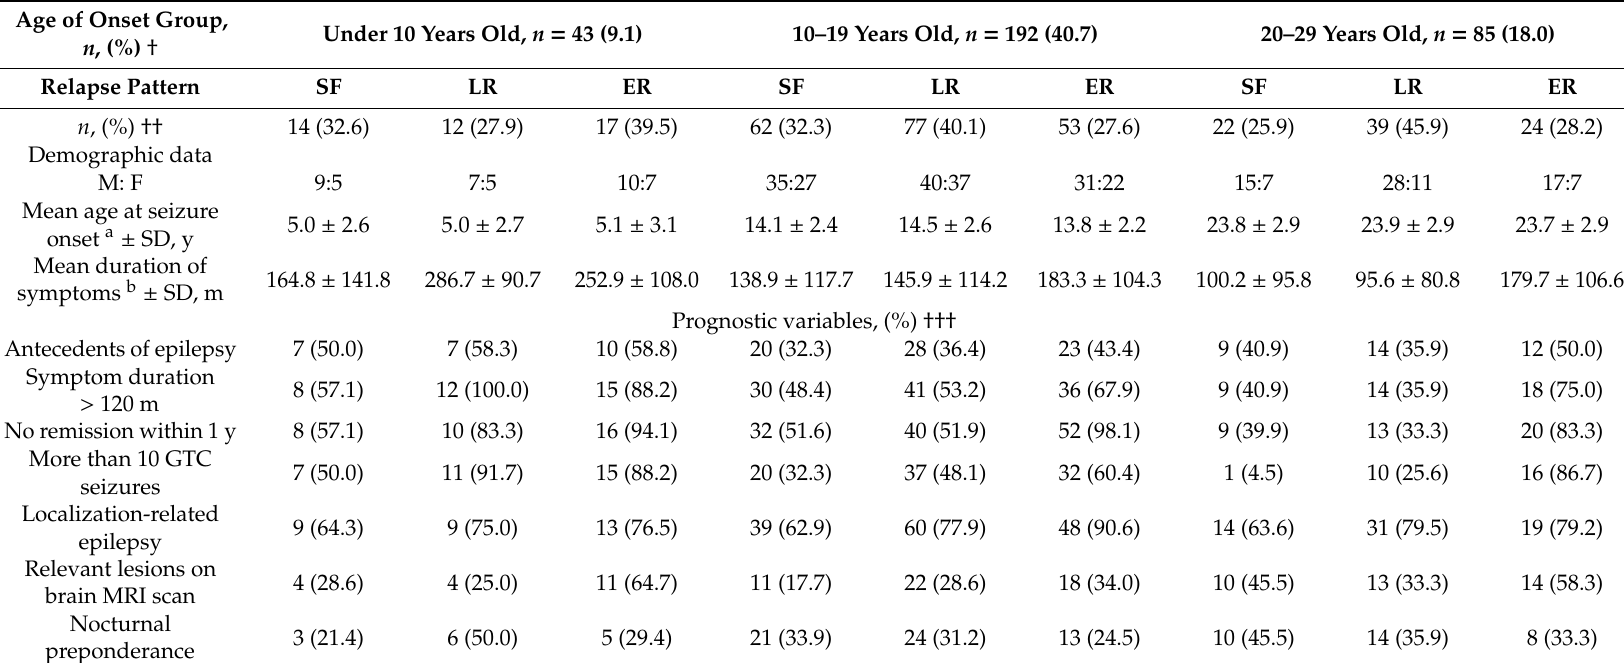
Table 1. Demographic data and prognostic variables according to relapse pattern in groups stratified by age of onset. Age of Onset